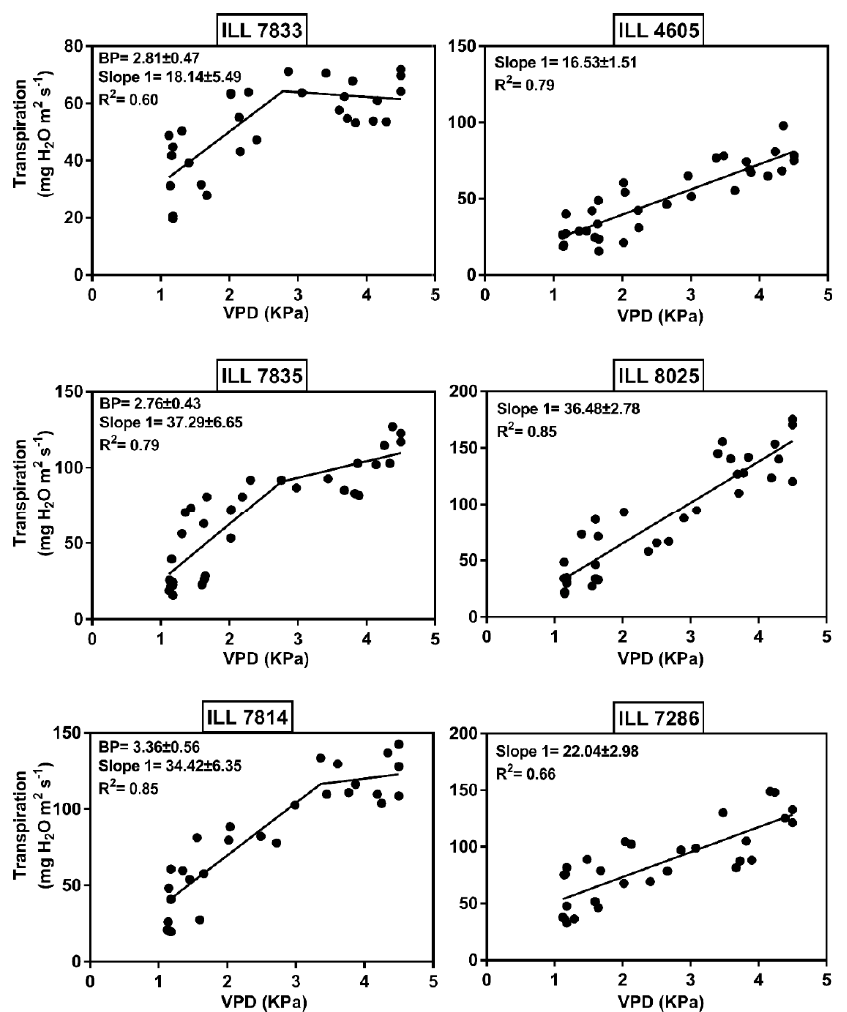
Figure 5. Transpiration rate (mg H 2 O m − 2 s − 1 ) response to increasing vapor pressure deficit (VPD in kPa). Genotypes ILL 7833, ILL 7835 and ILL 7814 represent tolerant accessions with two segmental regression, while ILL 4605, ILL 8025 and ILL 7286 represent susceptible genotypes with linear transpiration response to increasing VPD. The breakpoint (BP), slopes and R 2 are indicated.